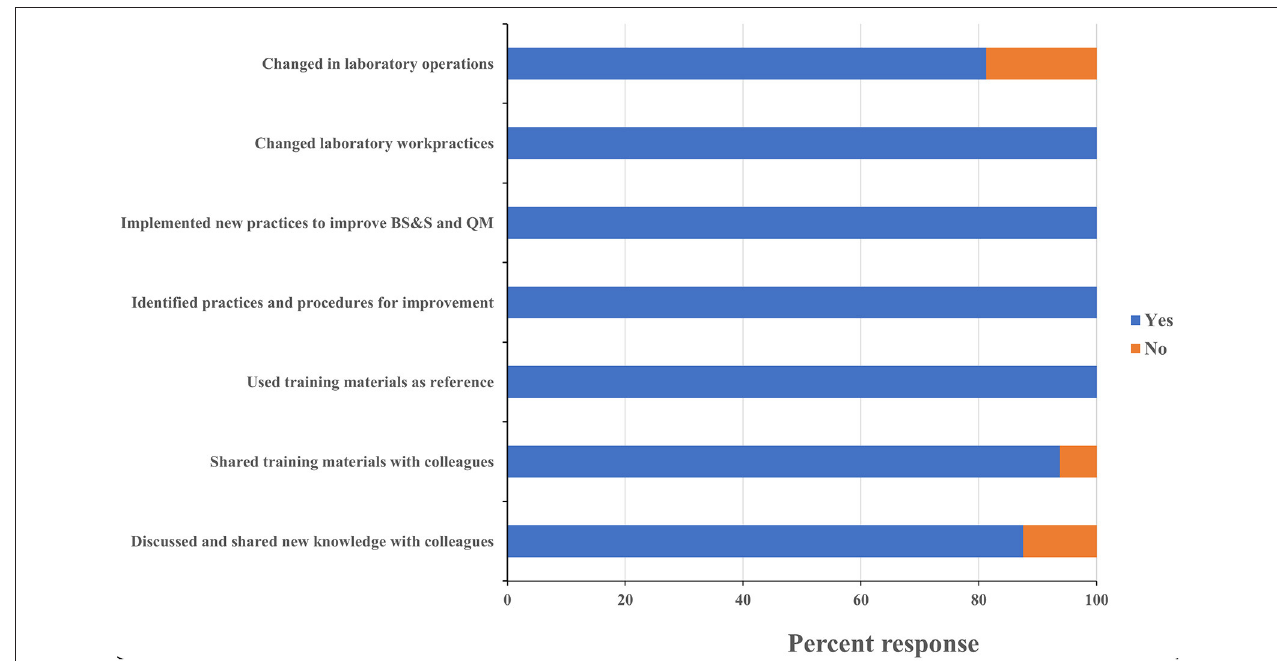
FIGURE 6 | Staff training sustainability. Questionnaires were designed to assess the sustainability of the lessons learnt and skills gained on staff participant’s professional activities at their institution. Trainees were asked to respond “yes” or “no” to each of these questions and the percentage of respondents selecting each answer was calculated. MoH, ministry of health; BS&S, biosafety and biosecurity; QM, quality